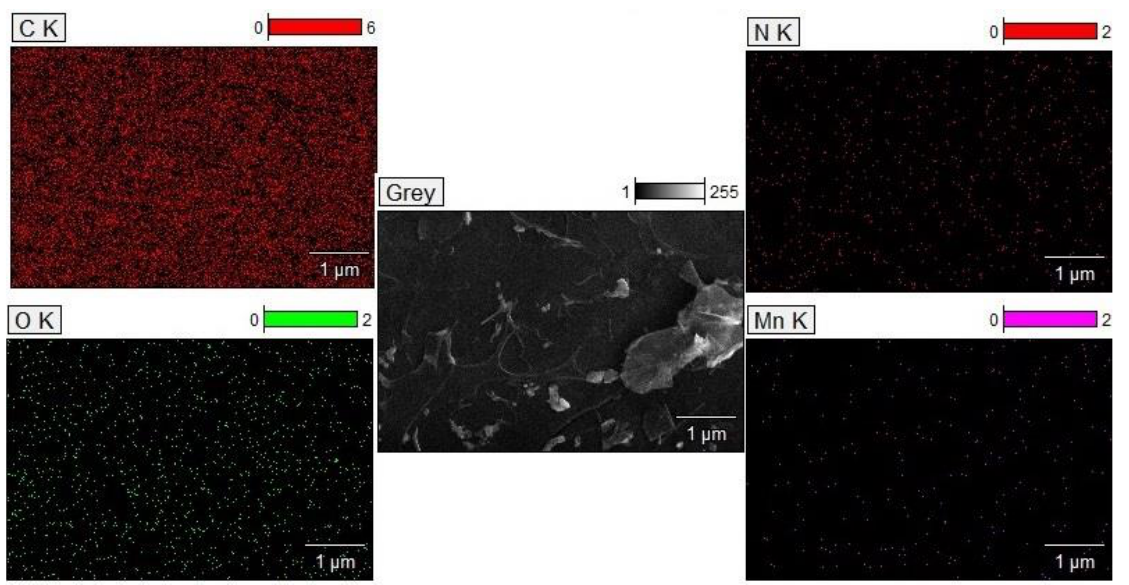
Figure 5. EDS elemental mapping analysis for Mn 3 O 4 @N-doped carbon: C mapping ( top left ), N mapping ( top right ), O mapping ( bottom left ), and Mn mapping ( bottom right ).